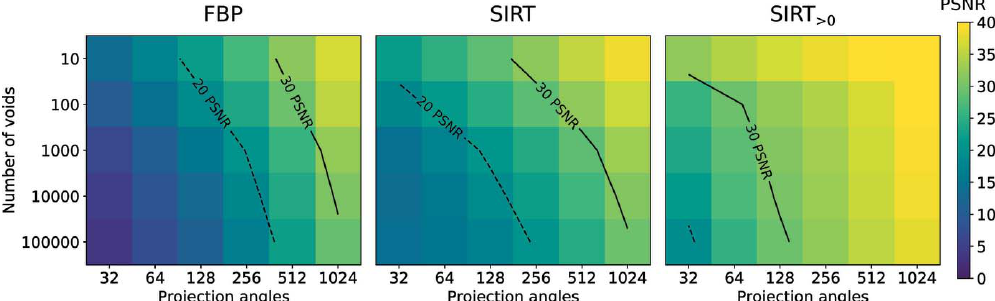
Figure 9 PSNR of reconstructed images of the central slice of a foam phantom as a function of the number of voids in the sample and the number of projection angles. Solid and dashed lines represent contour lines at 30 and 20 PSNR, respectively. Given are results for FBP, SIRT, and SIRT with an additional nonnegativity constraint (SIRT >0